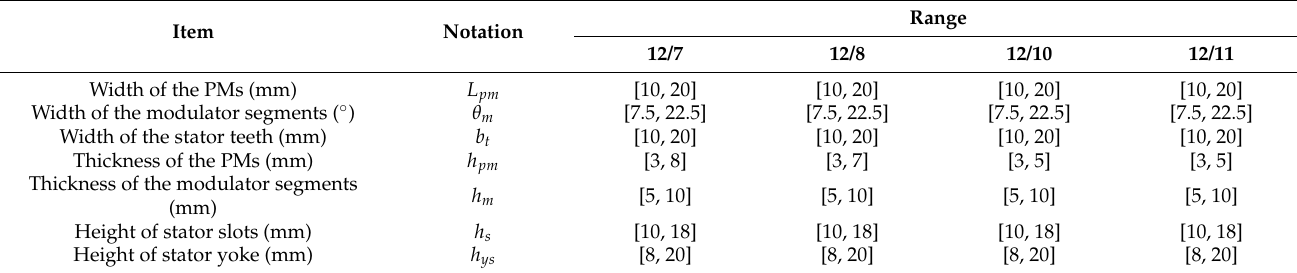
Table 3. The optimizing variables of